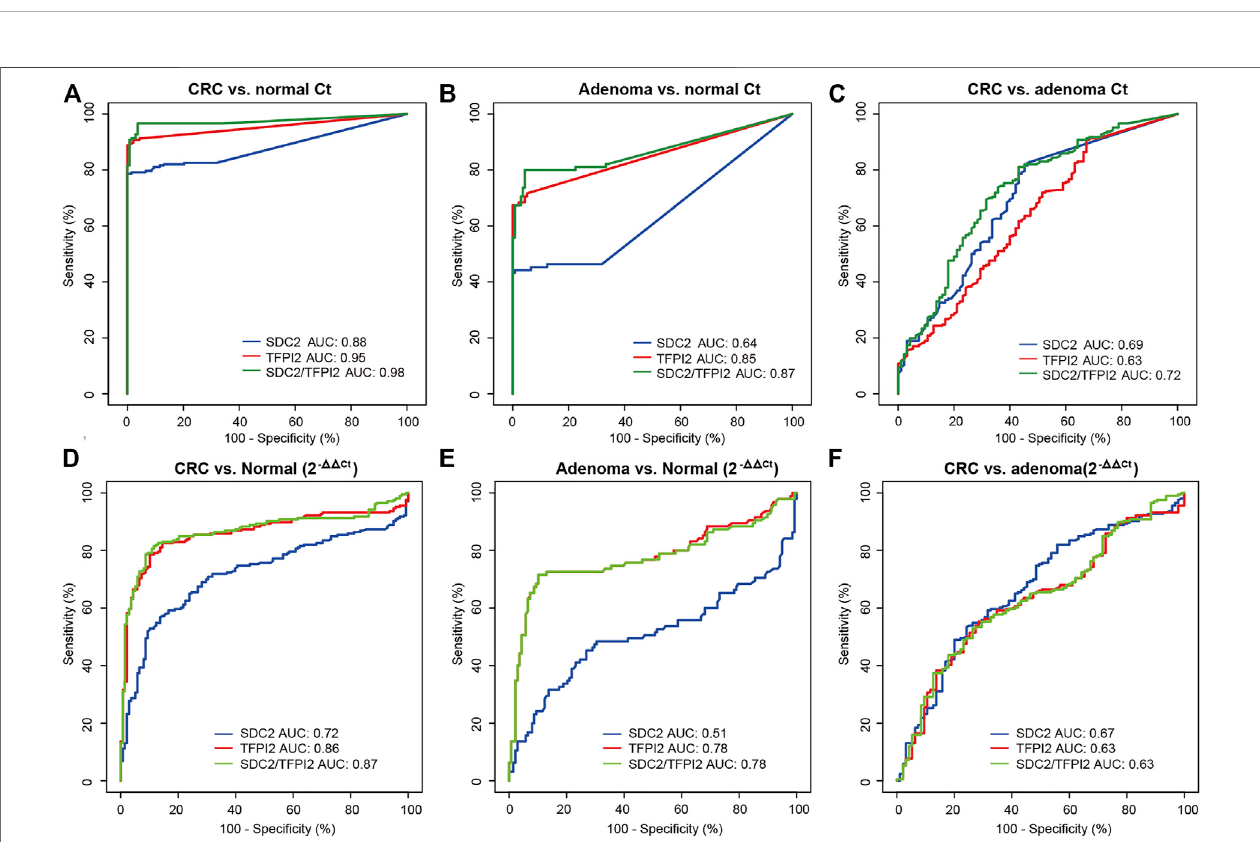
FIGURE 3 | Diagnostic performances of methylation-speci fi c PCR targeting SDC2 , TFPI2 , and SDC2/ TFPI2 in stool specimens. (A – C) are ROC curves based on Ct values, for cancer vs. normal, adenoma vs. normal, and cancer vs. adenoma, respectively. (D – F) are ROC curves based on ML values, for cancer vs. normal, adenoma vs. normal, and cancer vs. adenoma, respectively. Ct values are obtained in stool specimens by methylation-speci fi c PCR. ML (cid:1) 2- ΔΔ Ct , in which ΔΔ Ct (cid:1) (Ct target - Ct ACTB ) sample - (Ct target - Ct ACTB ) positive control . AUC means the area under the